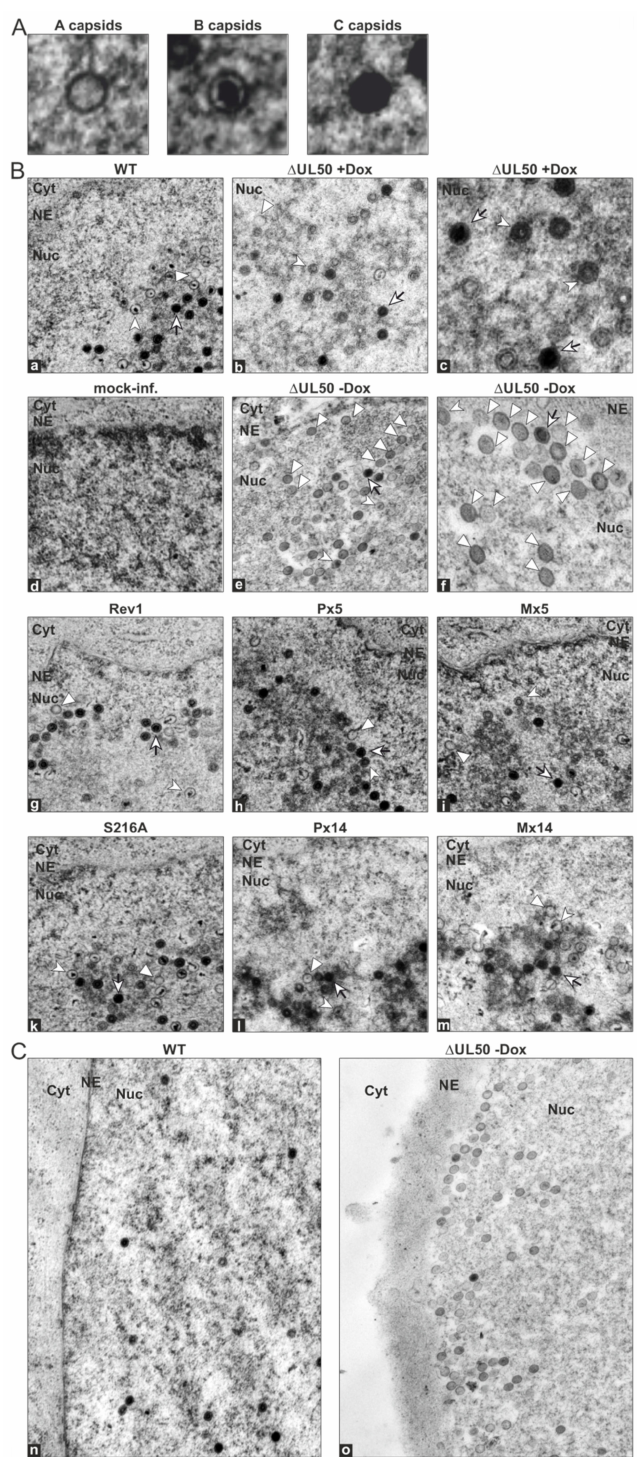
Figure 7. Electron microscopic analysis of viral nuclear capsid formation. HFFs were infected with parental WT, mutant or revertant HCMVs as indicated at a MOI adapted to maintain cell viability for harvesting and fixation at 4–7 d p.i., to be subjected to sectioning and negative staining in TEM. ( A ) Representatives of A-, B- and C-capsids. ( B ) Representative nuclei of infected cells at a 16,700-fold or 33,400-fold (c,f) magnification. The distribution of A- (white triangle), B- (white arrowhead) and C-capsids (white arrowhead with black tail) is depicted. NE, nuclear envelope; Cyt, cytoplasm; Nuc; nucleus. ( C ) Accumulation of capsids of HCMV ∆ UL50 in close proximity to the nuclear envelope in contrast to a more homogeneous distribution of the WT (25,050-fold